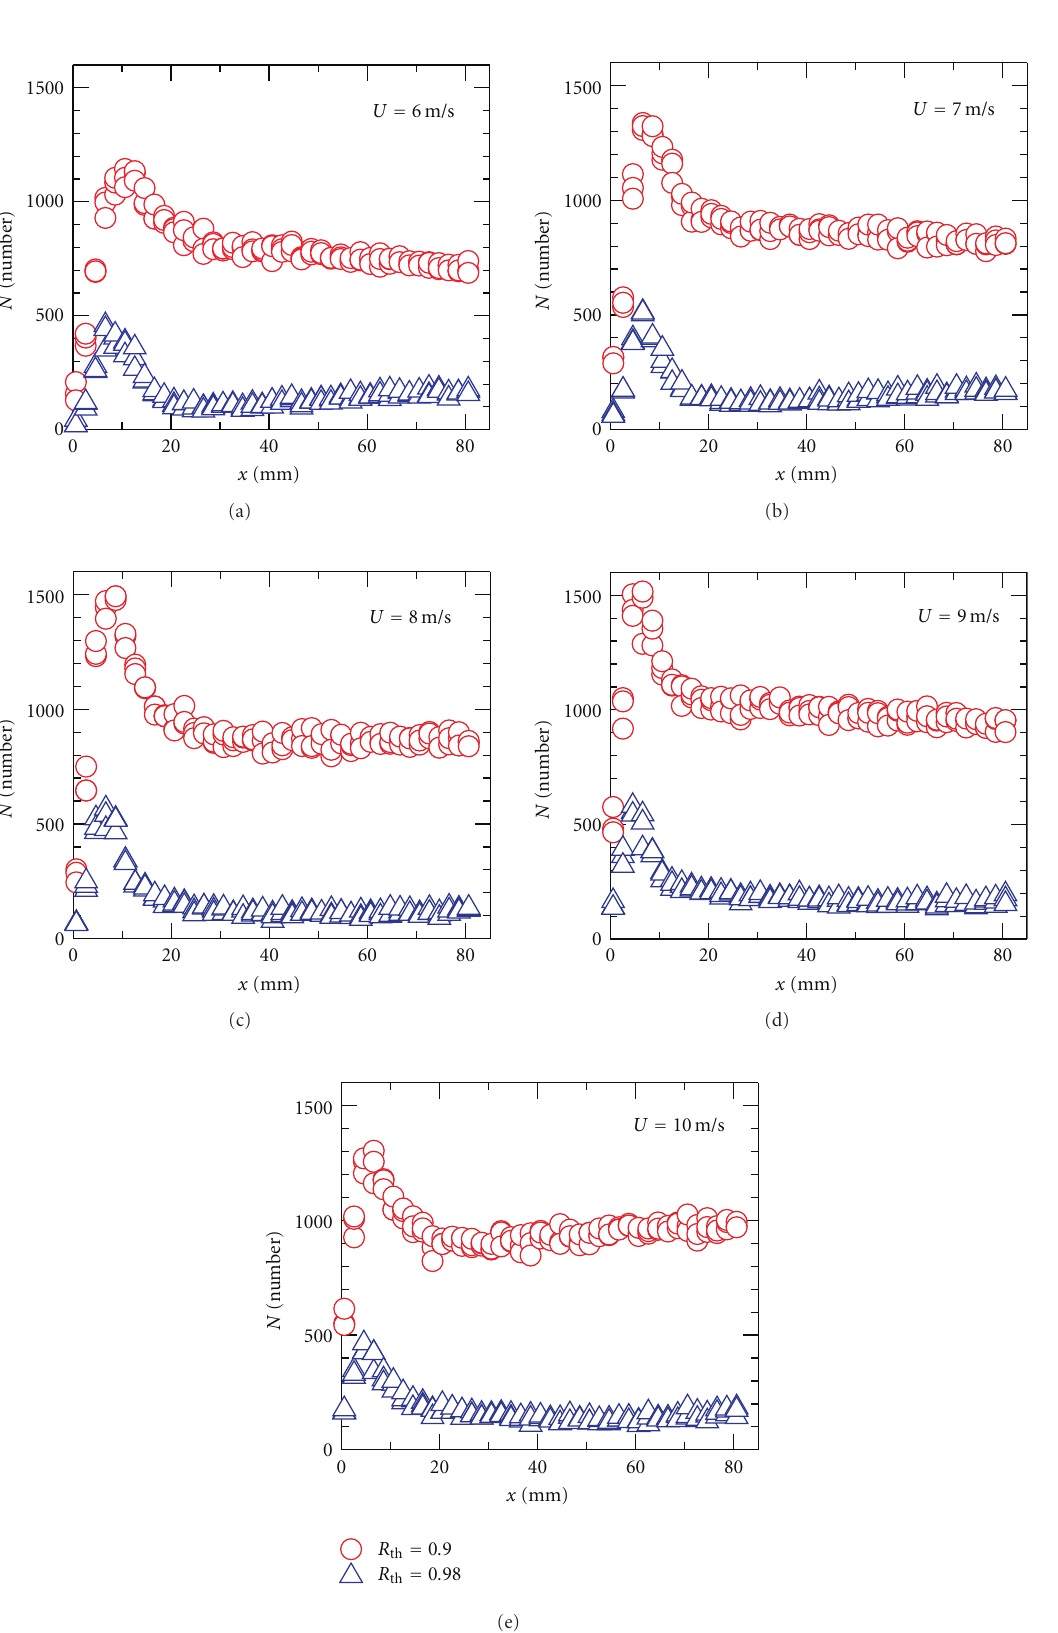
Figure 8: Number of identified free surface